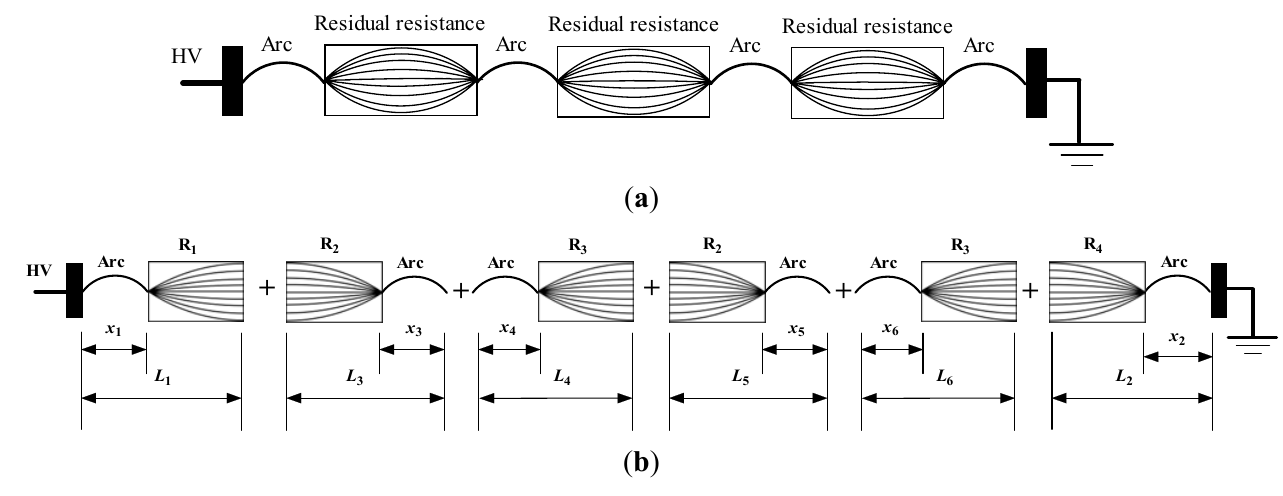
Figure 5. Equivalent single-arc residual resistance calculation model for four arcs. ( a ) Schematic for the two icicle-icicle air gap arcs in the middle; ( b ) Schematic for the division of the arc in the